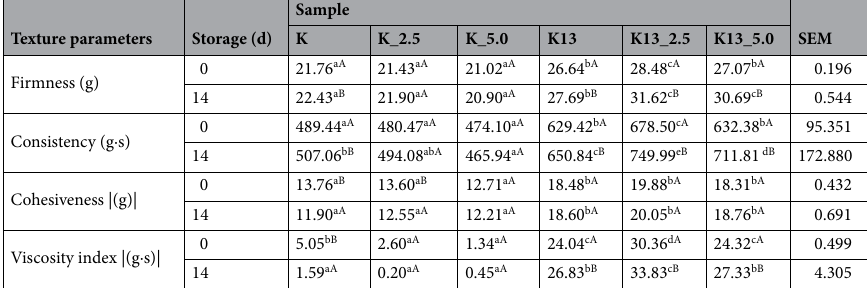
Table 3. Changes in texture parameters in kefir with honeydew honey during storage. K, model kefir; K13, commercial kefir; K_2.5, model kefir with 2.5% honeydew honey; K_5.0, model kefir with 5.0% honeydew honey; K13_2.5, commercial kefir with 2.5% honeydew honey; K13_5.0, commercial kefir with 5.0% honeydew honey; d, day; SEM, standard error of the mean (n = 8). a–e, A–B Different lowercase letters in the superscript in rows and capital letters in columns for each parameter indicate statistically significant differences at the level α =